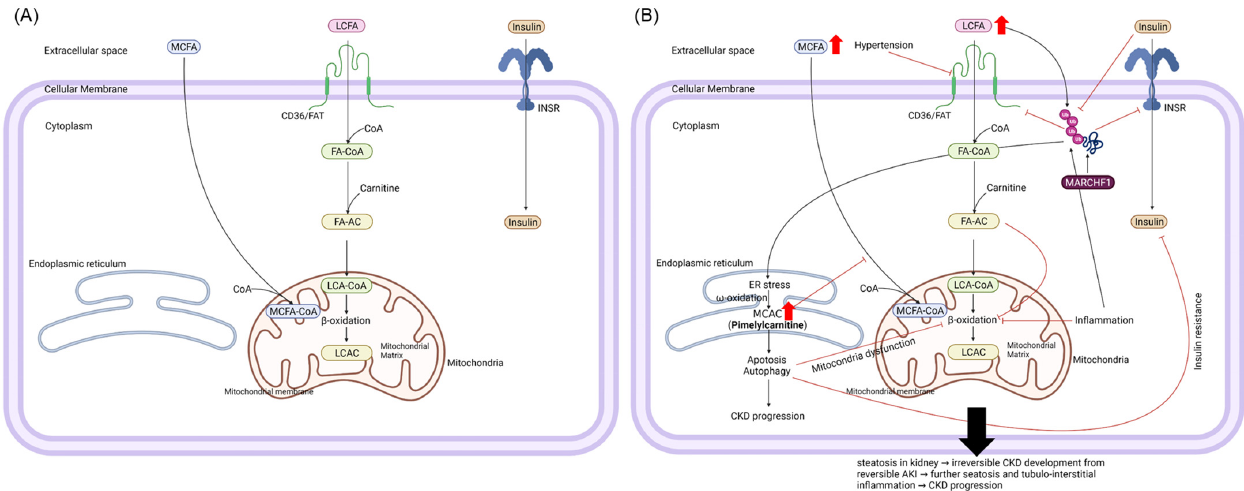
Figure 3. Biological mechanisms for the association between MARCHF1 and pimelylcarnitine are based on GMIA. An unusual metabolite, pimelylcarintine, may be an intermediator for CKD progression through oxidative stress on the endoplasmic reticulum. ( A ) Normal processes and ( B ) processes during CKD development influenced by the genetic variant of MARCHF1 , hypertension, and diabetes, and in CKD progression. AC, acylcarnitine; CKD, chronic kidney disease; ER, endoplasmic reticulum; FA, fatty acid; GMIA, genome–metabolomics integrative analysis; INSR, insulin receptor; LC, long-chain; MARCHF1 , Membrane-associated ring-CH-type finger 1; MC, medium-chain; Ub, ubiquitin. Figures created with BioRender.com.